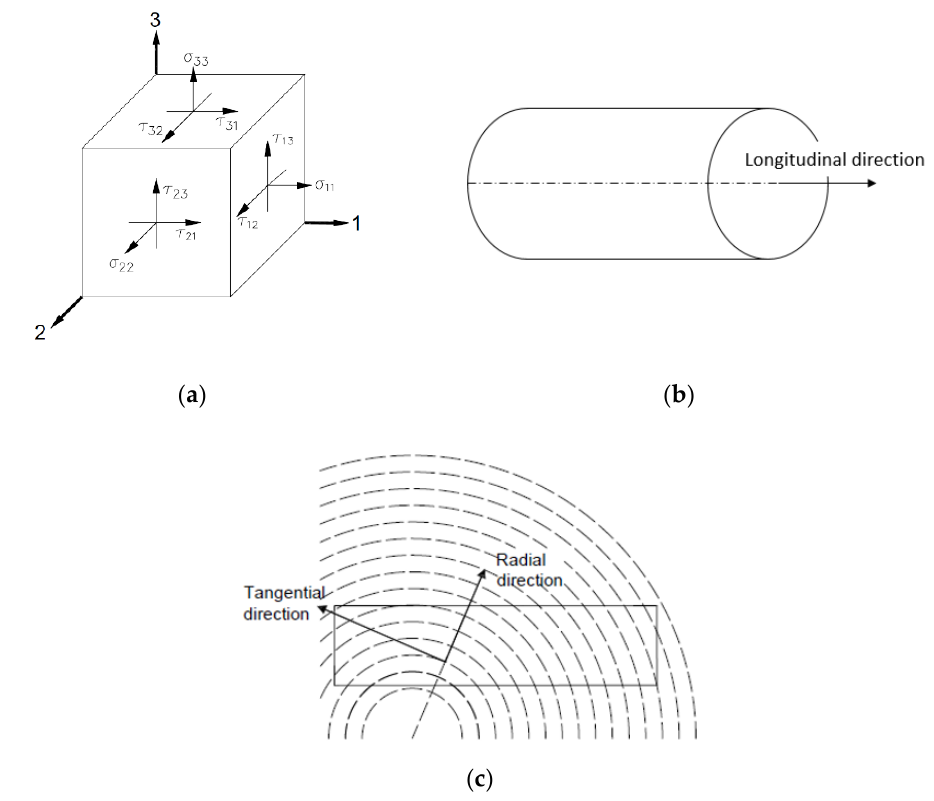
Figure 2. ( a ) Stresses relevant to an orthotropic material, ( b ) longitudinal direction for timber, and ( c ) cross-section showing radial and tangential directions in radial–tangential plane (cross-section).